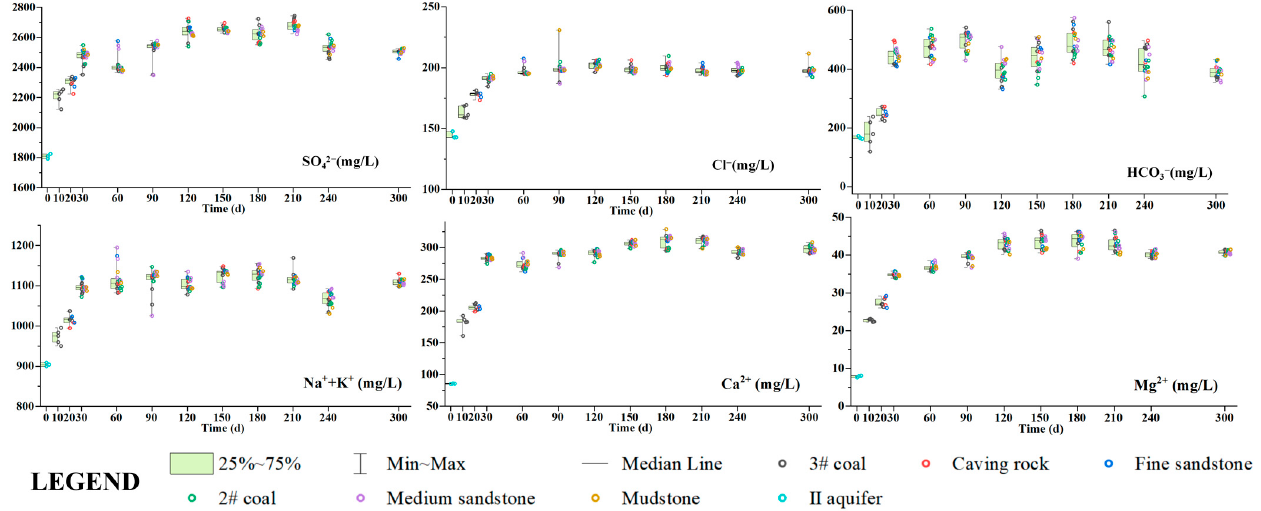
Figure 5. Half-box-and-whisker diagrams of changes in the concentration of ions.